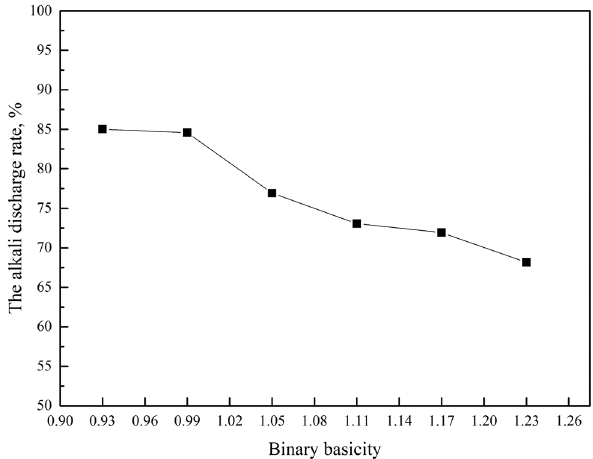
Figure 7: E ff ect of Al 2 O 3 on slag alkali metals discharge.